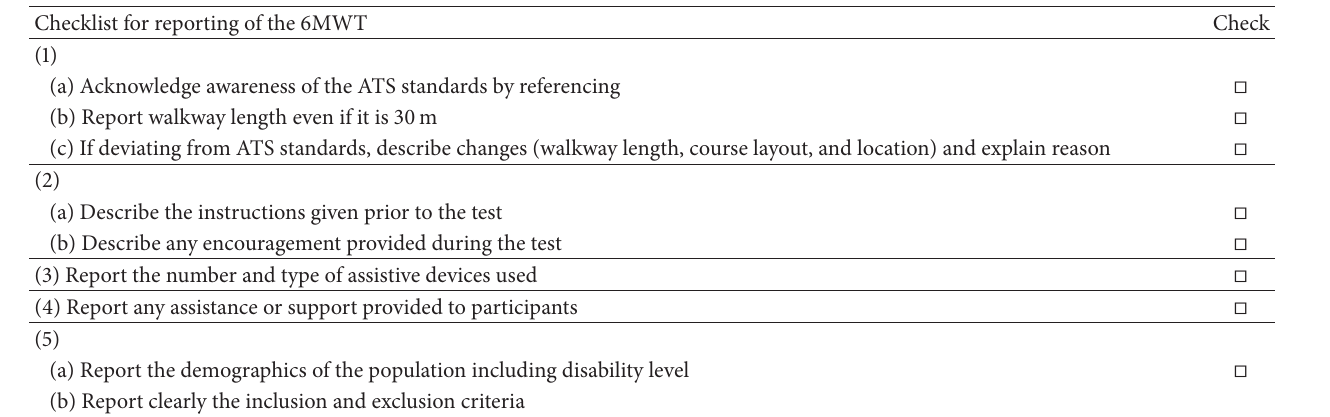
Table 5: Checklist for reporting of the